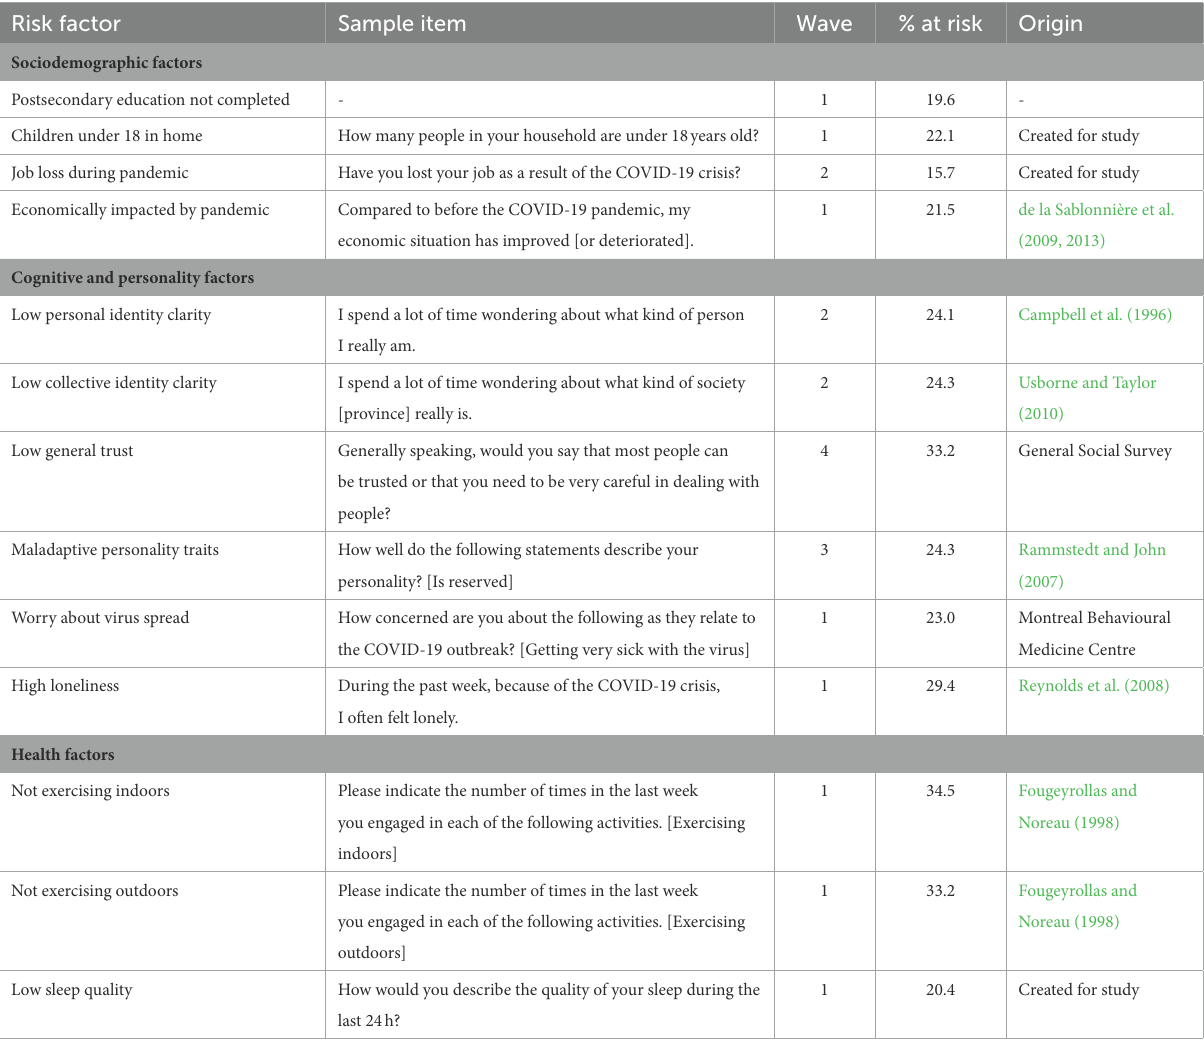
TABLE 1 Risk factors and proportion of sample considered at